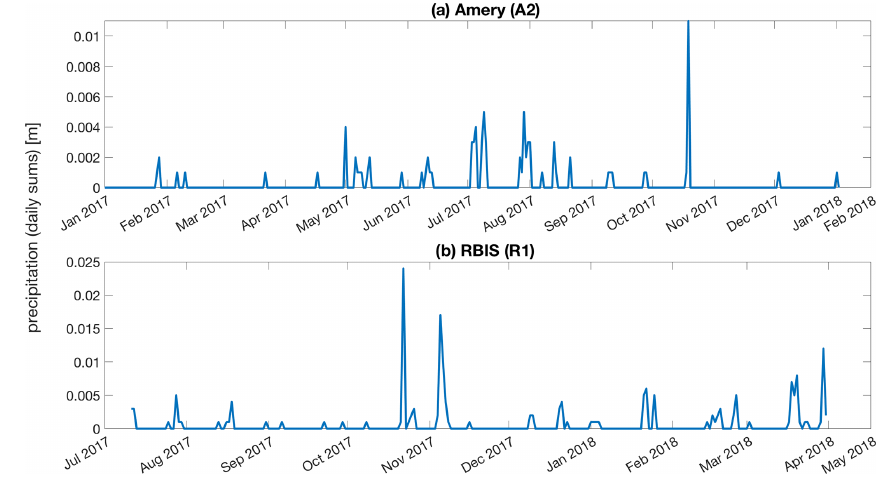
Figure 5. Precipitation time series spatially averaged over regions A2 and R1 (shown in Fig. 1) from ERA5, acquired from Google Earth Engine (Gorelick et al., 2017).